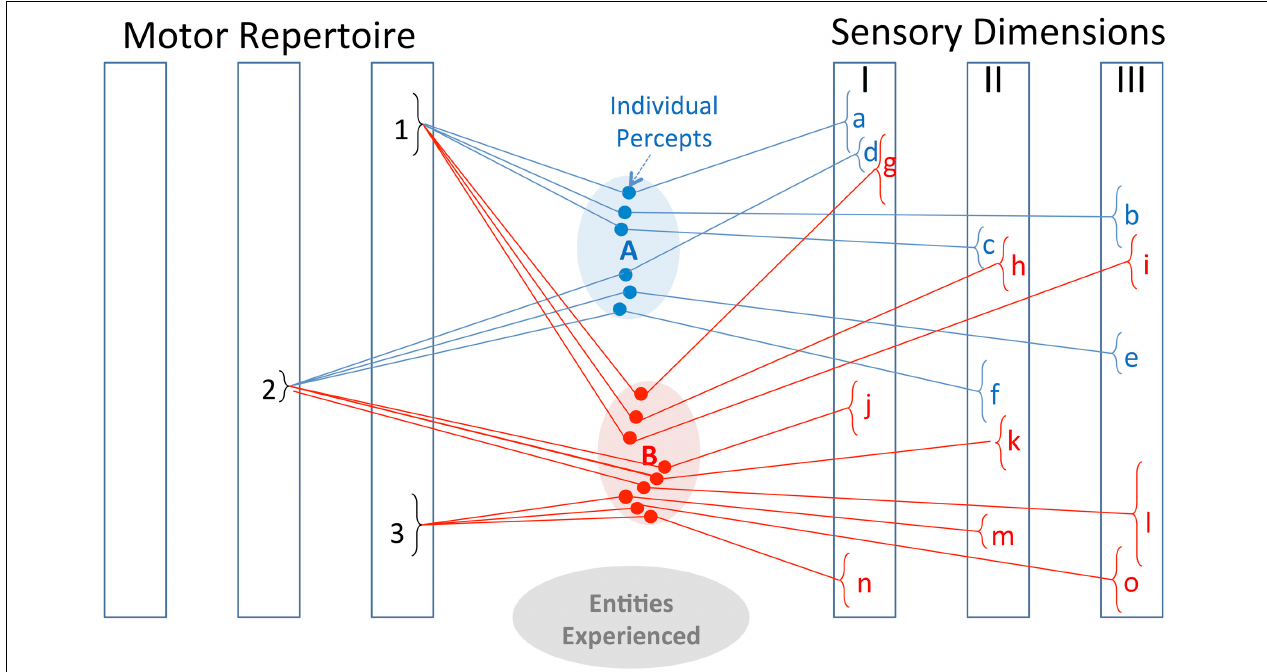
FIGURE 2 | Bayesian representation. The internal representations of entities A and B consist of the previously experienced associations of various motor behaviors with various sensory feedback. The motor repertoire consists of discrete types of movements with continuously adjustable parameters; the sensory dimensions represent processed sensations with continuous ranges of values. Discrimination and identification of entities depends on finding motor-sensory associations that distinguish among the alternatives that are currently most probable. When explored by motor strategy 1, entities A and B result in overlapping sensory percepts a, b, c and